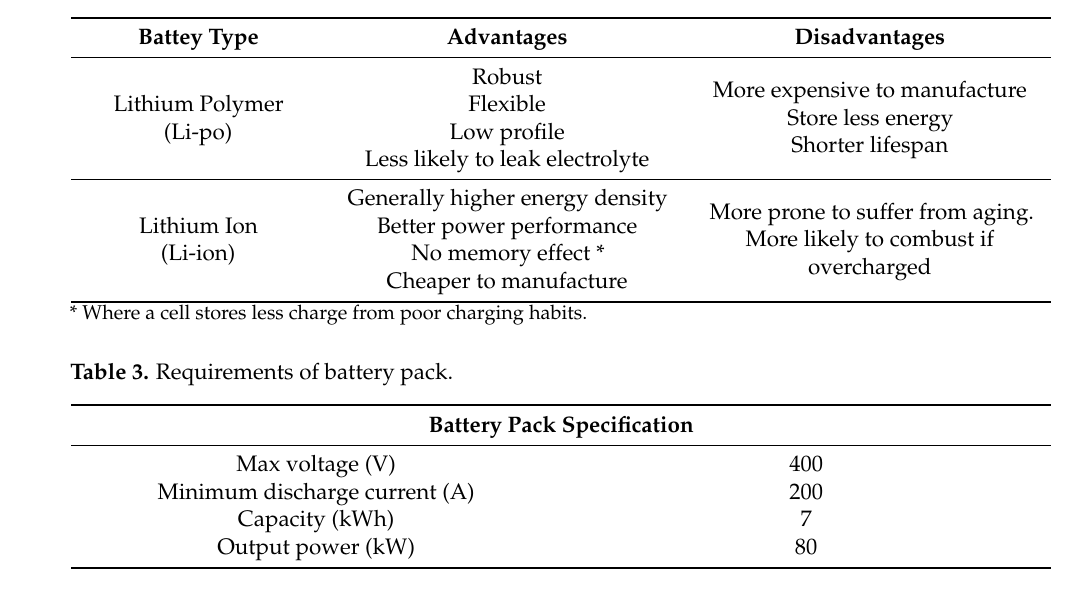
Table 2. Lithium-polymer (Li-po) vs. lithium-ion (Li-ion).